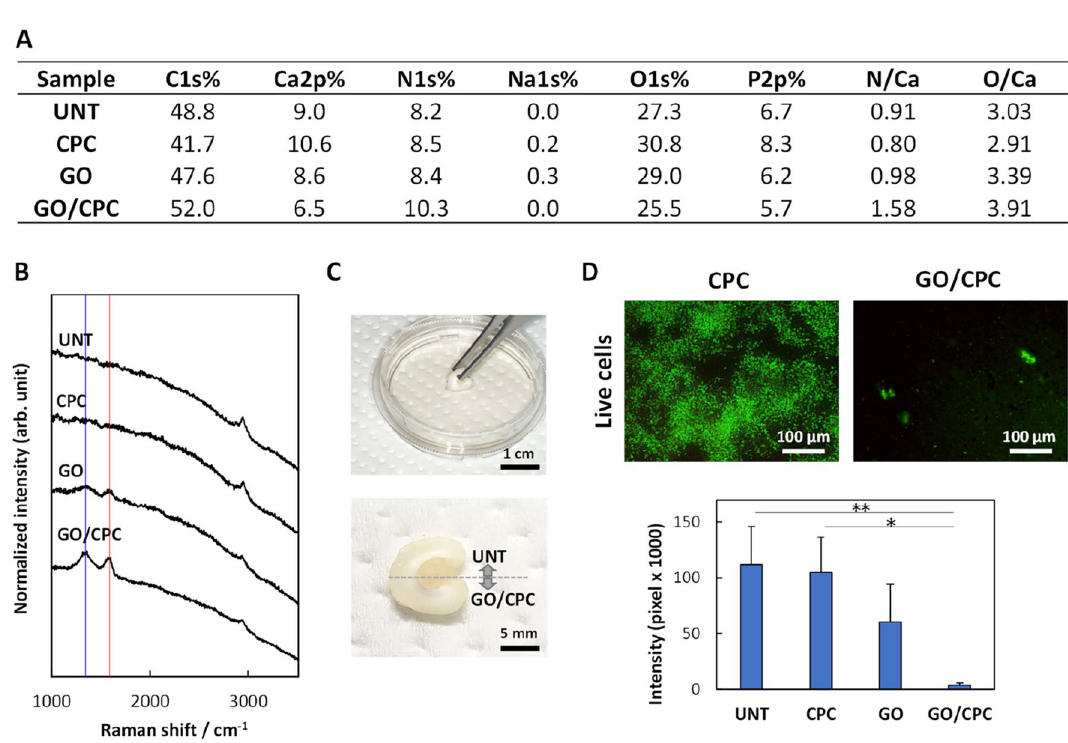
Figure 7. Characterization and antibacterial activity of GO/CPC on human tooth substrate. ( A ) XPS elemental analysis. ( B ) Raman spectroscopy analyses. The red and blue lines indicate 1600 cm -1 and 1350 cm -1 (G and D bands), respectively. ( C ) Digital images of tooth substrate coated with GO/CPC. Only the lower half of the tooth substrate was immersed in 0.01% GO dispersion (top). No color change was observed of the GO/ CPC coated area compared to UNT (bottom). ( D ) Fluorescent staining (top; green indicates live S. mutans ) and quantification of the staining intensity of S. mutans cultured on each tooth substrate (bottom; n = 3, mean + standard deviation). *P < 0.05, **P < 0.01. Statistical analysis: two-tailed one-way ANOVA with post-hoc Tukey HSD test. CPC cetylpyridinium chloride, GO graphene oxide, UNT